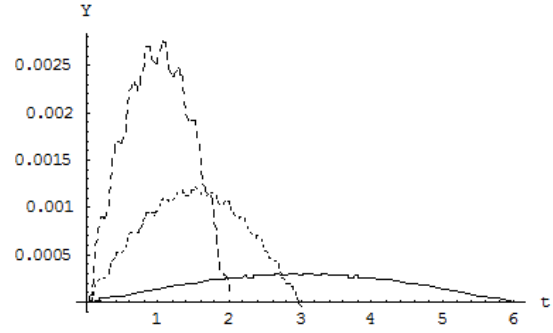
Figure 8: The influence of the speed for R = 50 m, e H = 0 m and υ = 10 m/s ( ___ ), υ = 20 m/s (......), υ = 30 m/s ( - - - ).